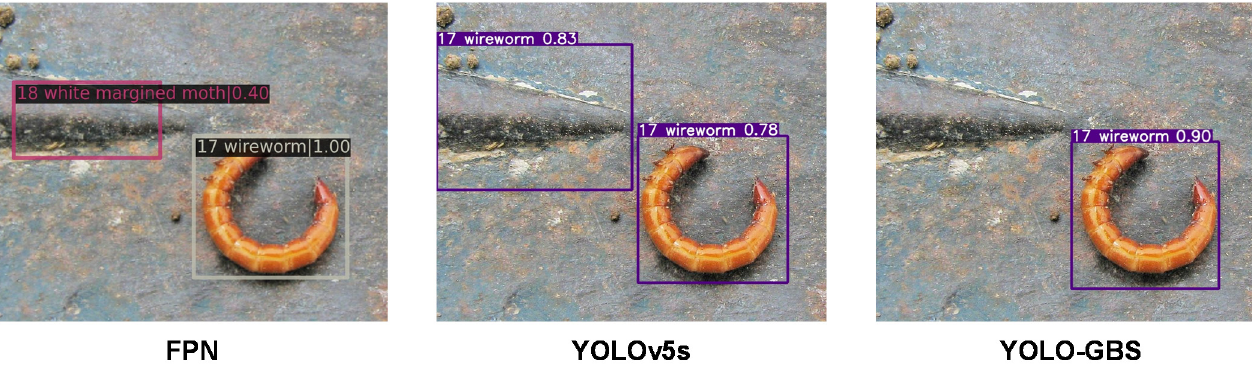
Figure 12. YOLO5s and FPN misdetection of the upper left background of the figure as insects.